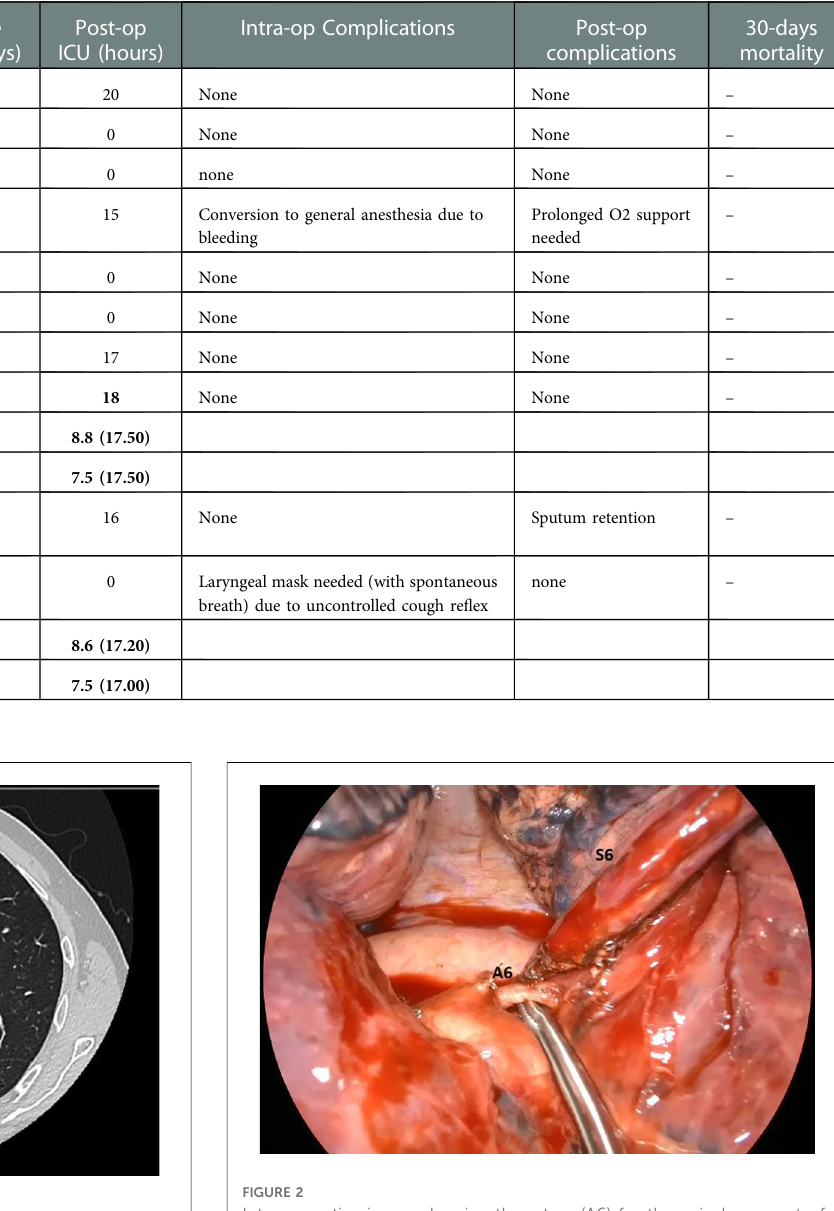
TABLE 3 Early post-operative outcomes. ICU: Intensive Care Unit; WR: Wedge Resection.